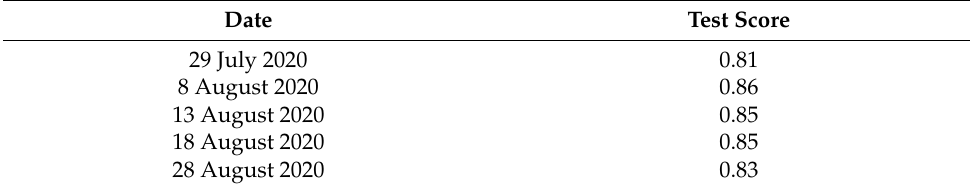
Table 14. Test score for the test 2020 rice crop with the 2019 calibrated